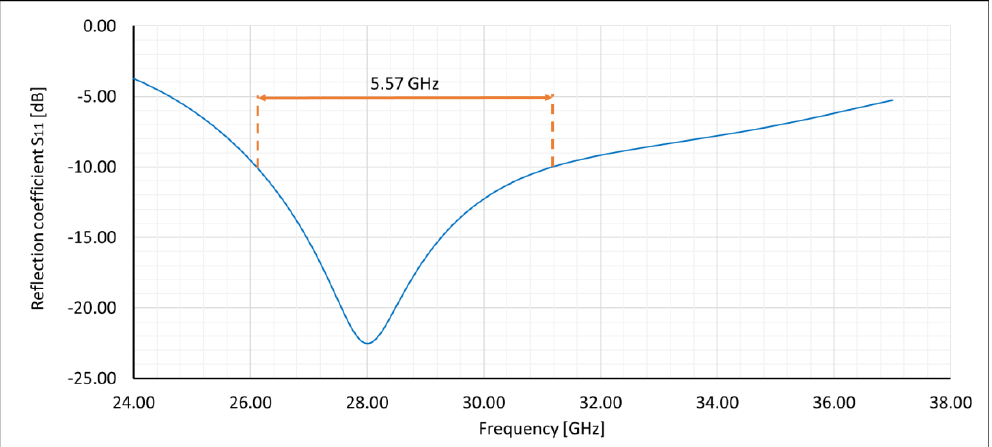
Figure 5. The reflection coefficient as a function of frequency for the proposed antenna working in the fifth generation (5G) system.